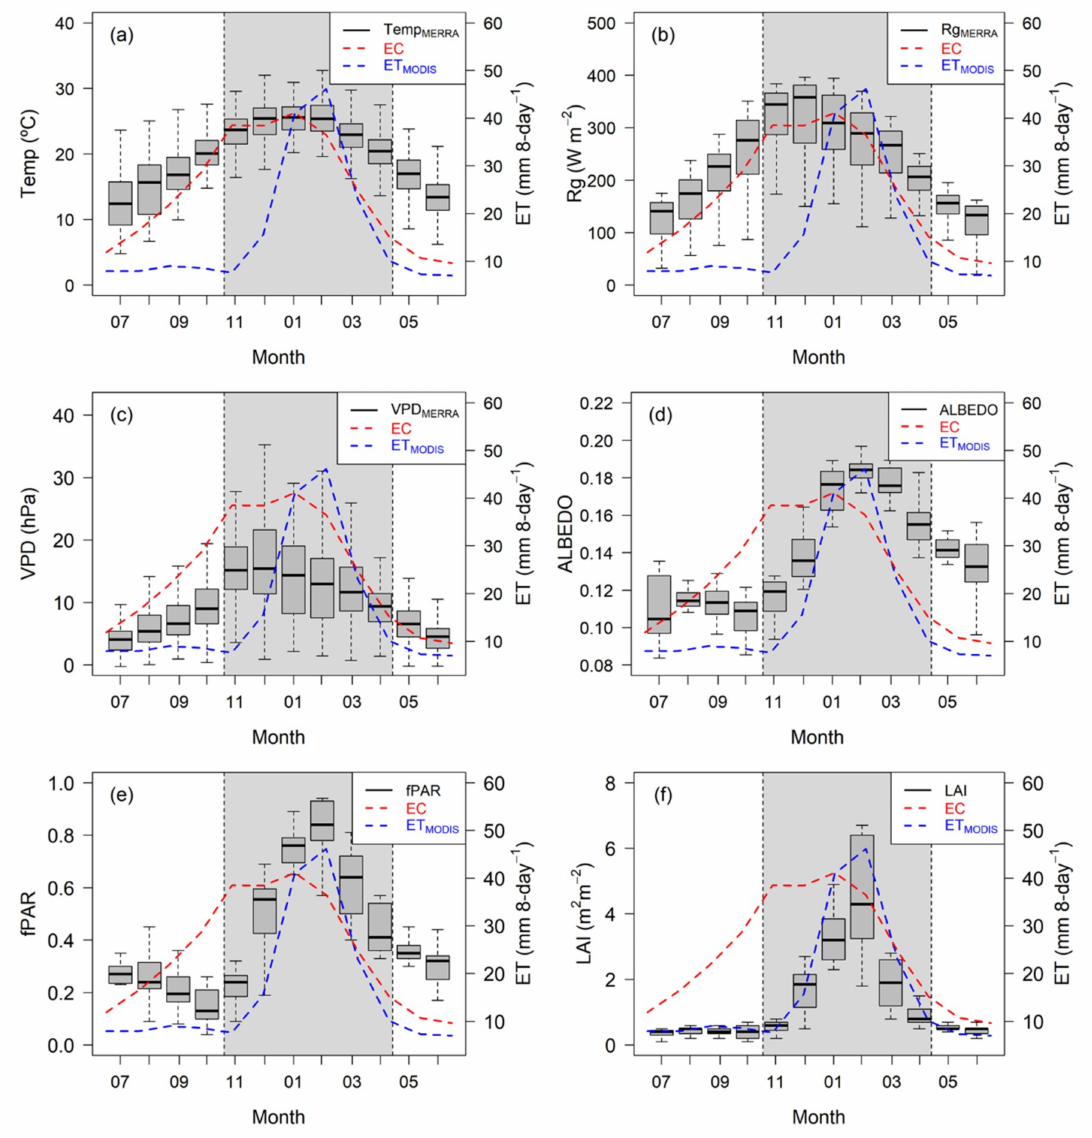
Figure 6. Average seasonal pattern of EC measurements, MOD16 ET estimates and environmental variables (derived from MODIS remote sensing and MERRA reanalysis) from 2011 to 2014 at the CAS site. The grey boxes represent the inter-quartile range (IQR), the black tick lines represent the median and the whiskers indicate variability outside the upper and lower